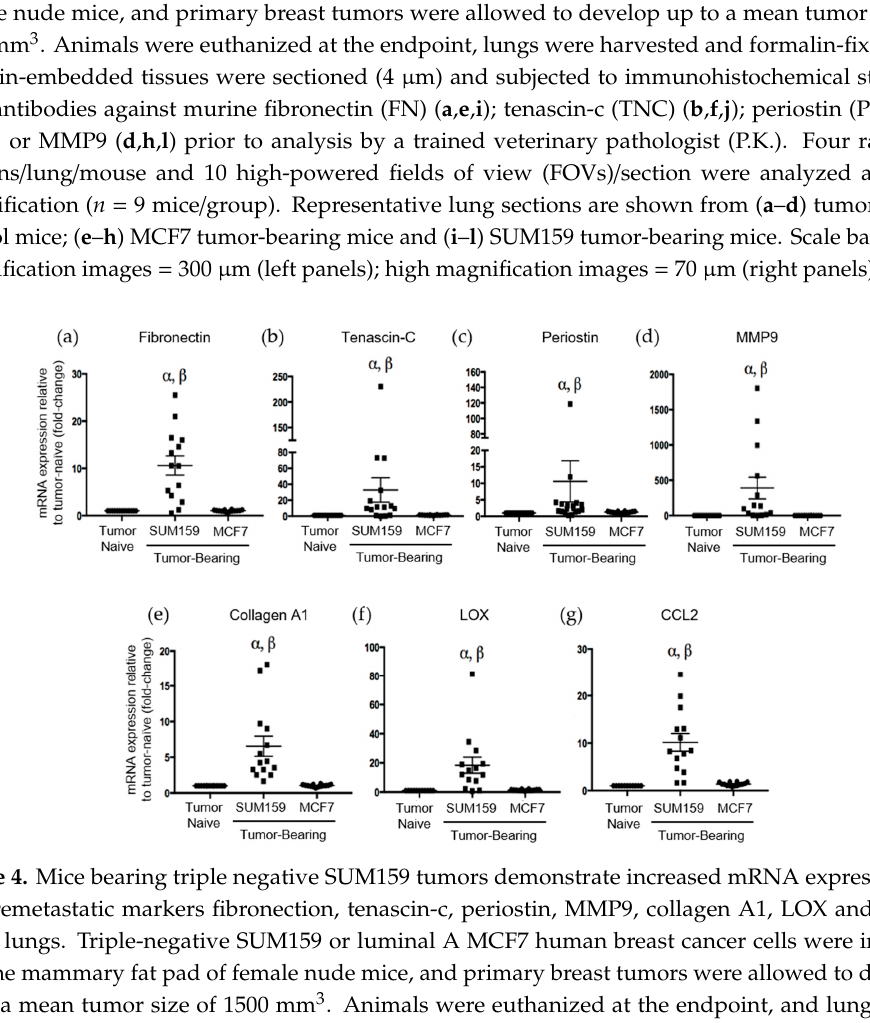
magnification ( n = 9 mice / group). Representative lung sections are shown from ( a – d ) tumor-naïve